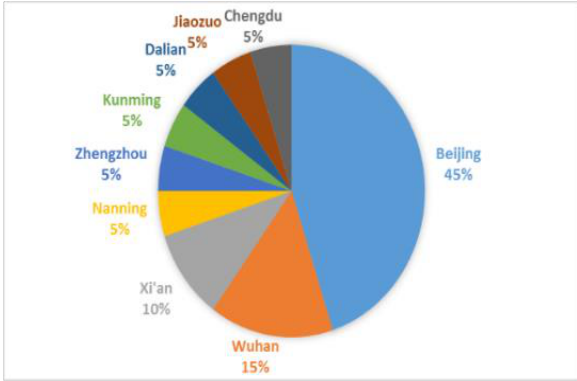
Fig.7 Geographical distribution of authors (number of published paper above